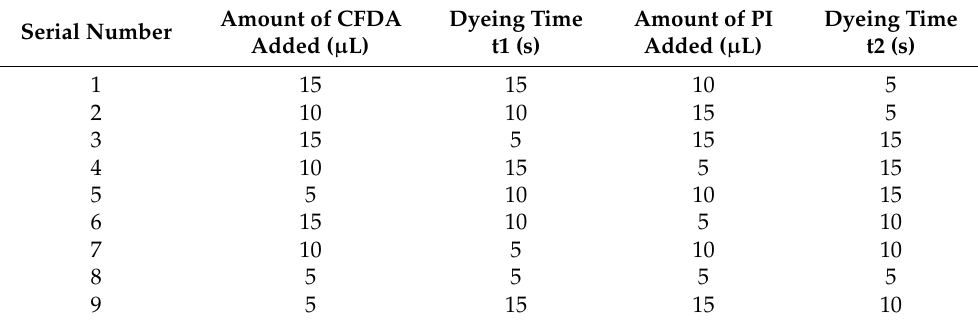
Table 2. Orthogonal experimental design of dye addition amount and dyeing